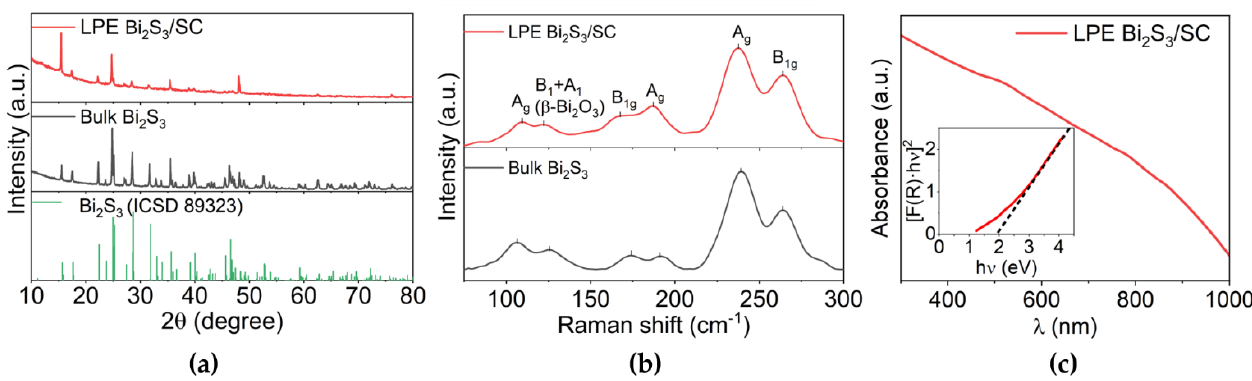
Figure 2. ( a ) P − XRD patterns, ( b ) Raman spectra and ( c ) UV–VIis–NIR absorption spectrum of LPE Bi 2 S 3 /SC. Tauc plot of LPE Bi 2 S 3 /SC is inserted in Figure 2c. For XRD and Raman, comparison with bulk Bi 2 S 3 is reported.